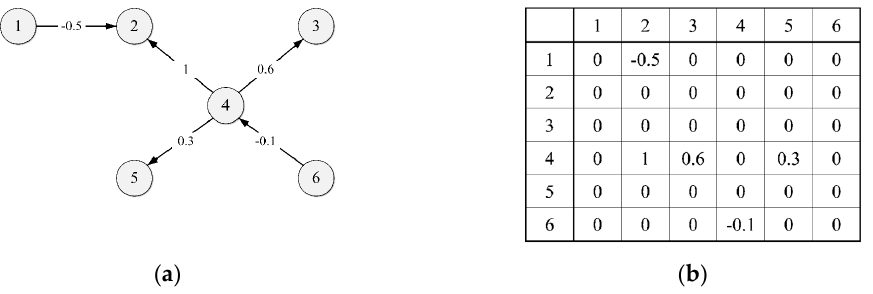
Figure 2. An example of a fuzzy cognitive map (FCM) and its equivalent weight matrix. ( a ) Graph Representation, ( b ) Matrix Representation.